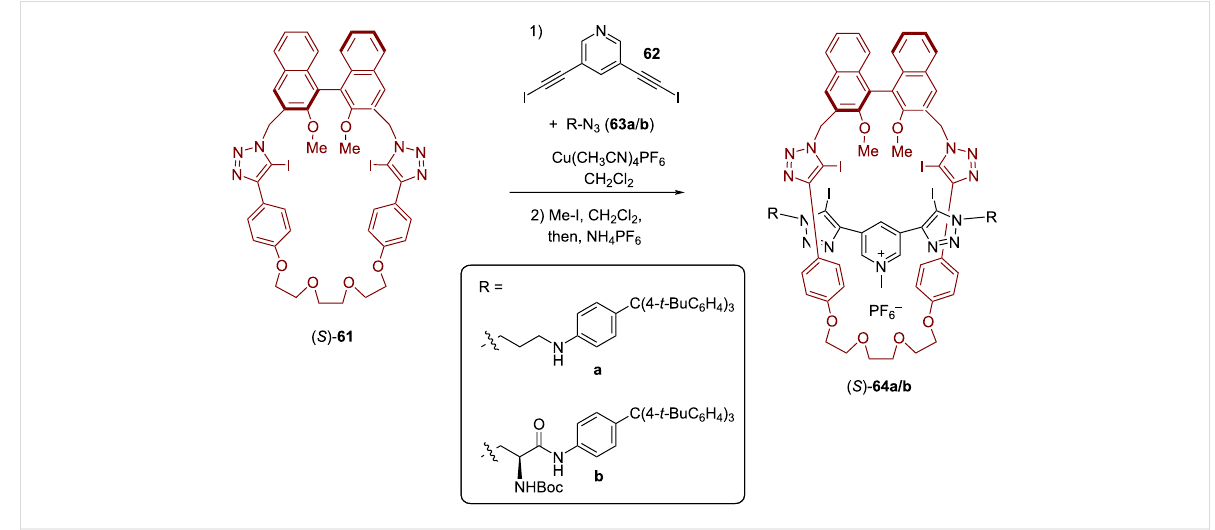
Figure 16: Synthesis of Beer´s [2]rotaxanes 64a / b for anion recognition.